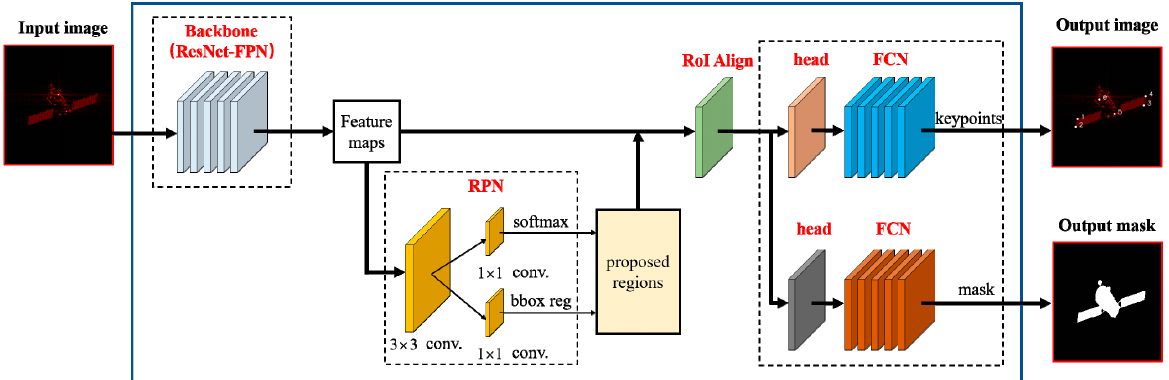
Figure 3. The structure of the KeyPoint R-CNN.